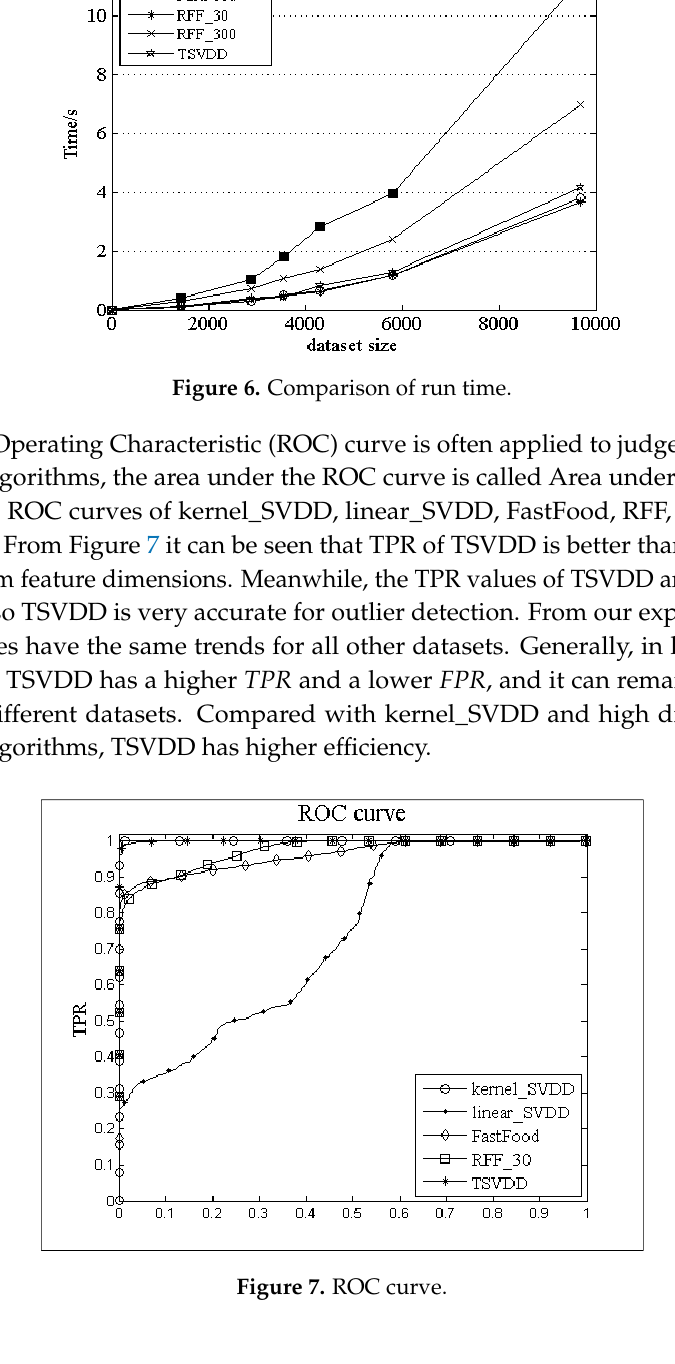
(f) Figure 5: Decision models trained by different algorithm on SS_12-3 dataset ( a ) kernel_SVDD model; ( b ) linear_SVDD model; ( c ) FastFood model; ( d ) RFF_30 model; ( e ) RFF_300 model; (f) TSVDD model